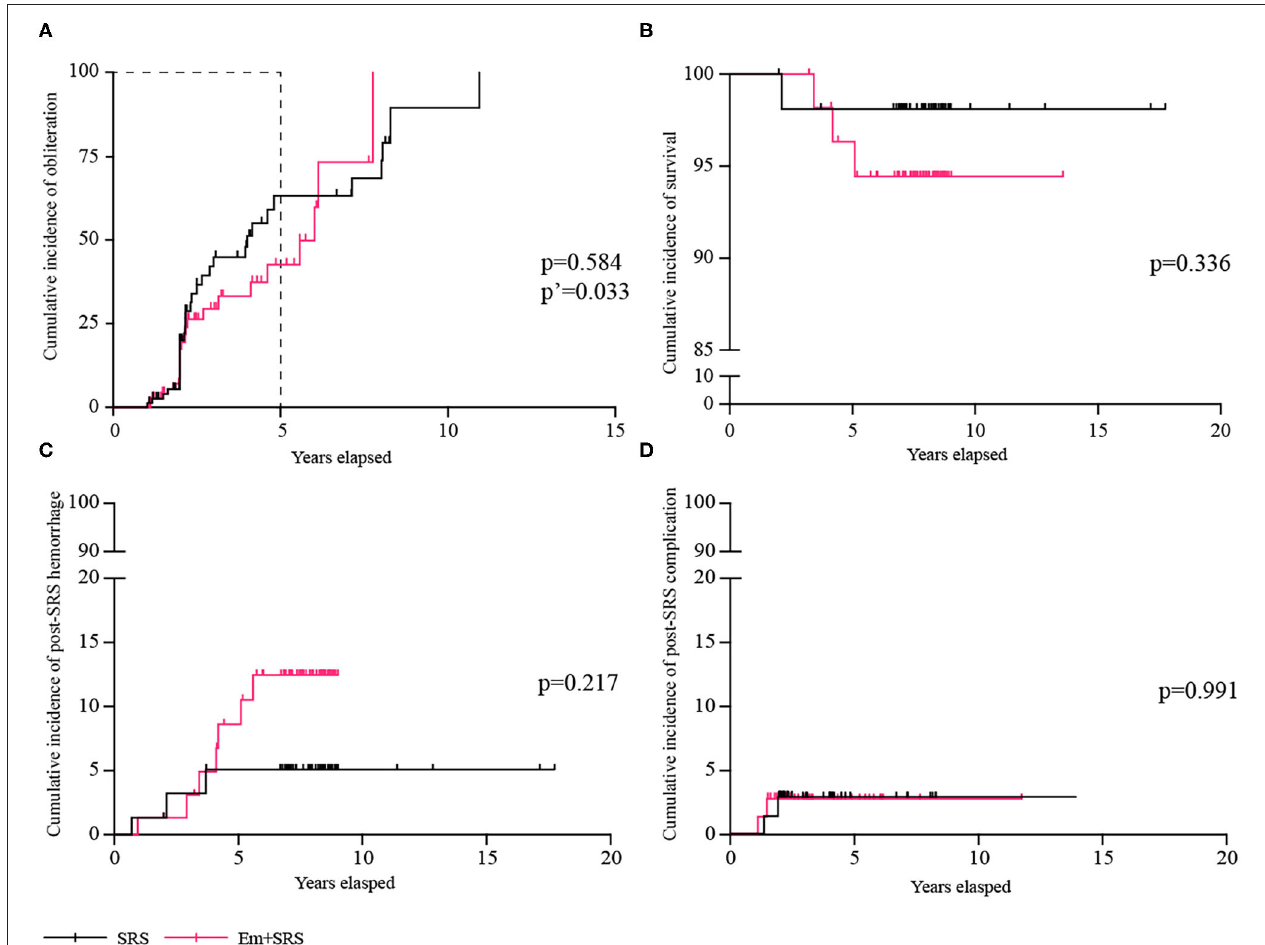
FIGURE 2 | Comparisons of cumulative incidence between SRS and Em + SRS. (A) AVM obliteration. (B) Survival. (C) Post-SRS hemorrhage. (D) Post-SRS complication. AVM, arteriovenous malformation; Em + SRS, embolization + stereotactic radiosurgery. p ′ -Value refers to the result of a 5-year